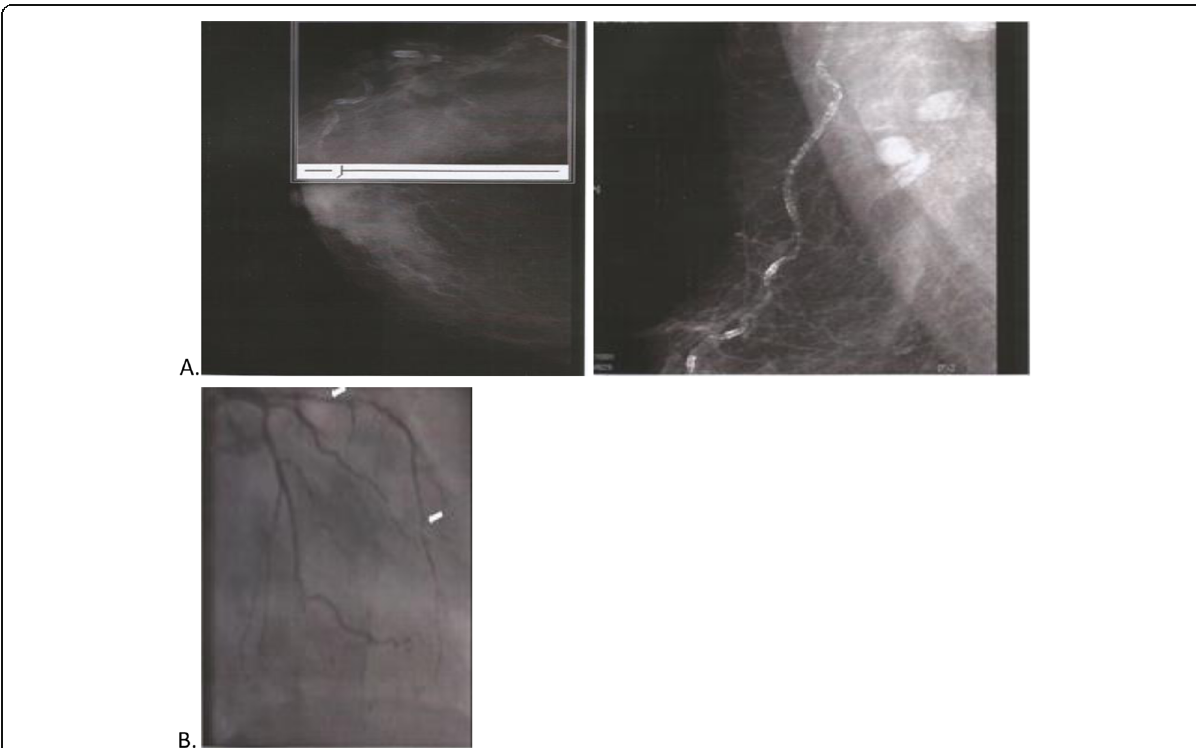
Fig. 2 a 68-year-old female patient known HTN, dyslipidemia, and chest pain on exertion, patient ’ s CT coronary angiography revealed 90% stenosis of the proximal and mid part of left anterior descending artery. CC and MLO mammography images showing unilateral BAC. b Stenosis of LAD as seen in cardiac catheterization